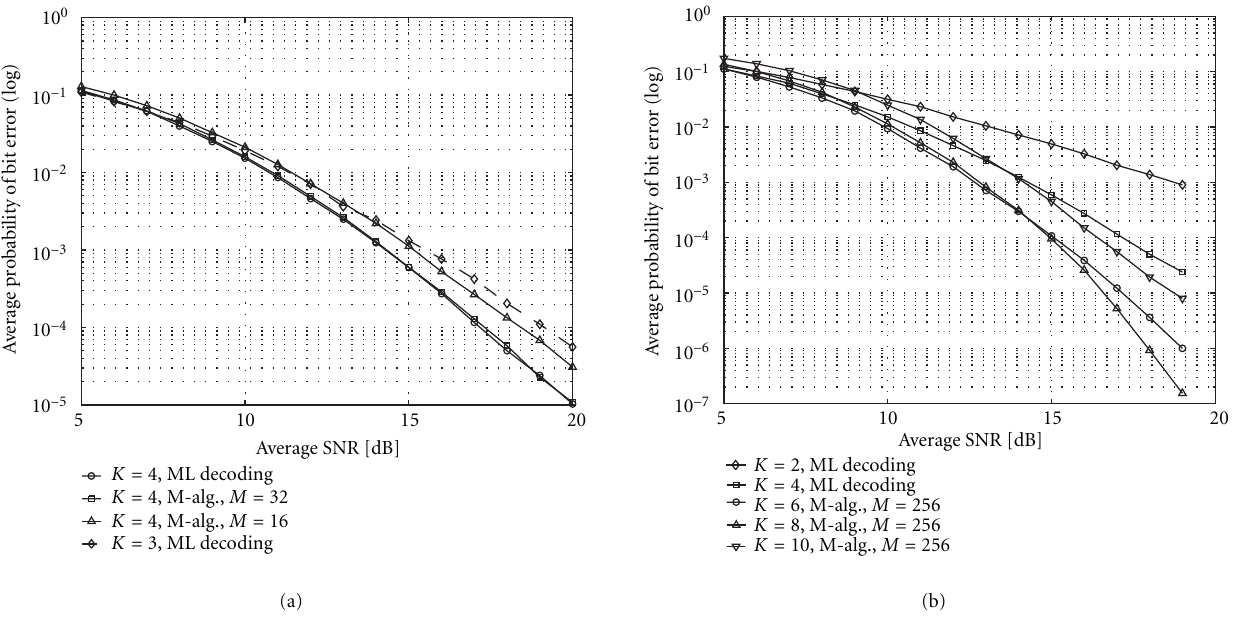
Figure 8: Simulation results IV. (a) Four antennas, suboptimal decoding, (b) ST codes for QPSK modulation.